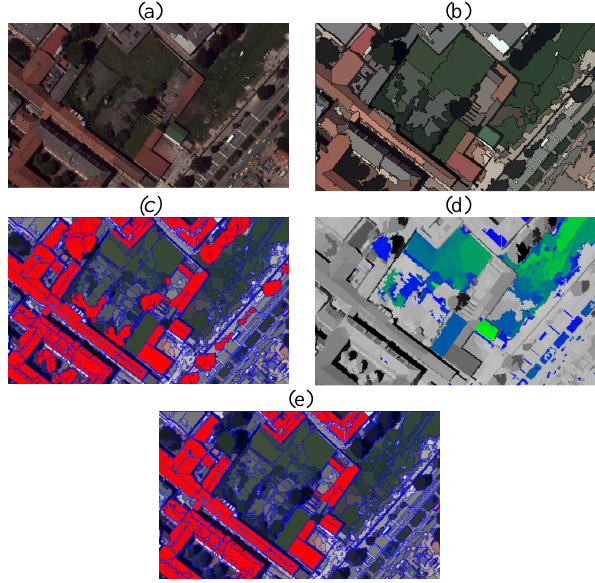
Figure 6. Automatic Segmentation Process for buildings. It exhibits the sequence of application of the different algorithms and refinements. Source: